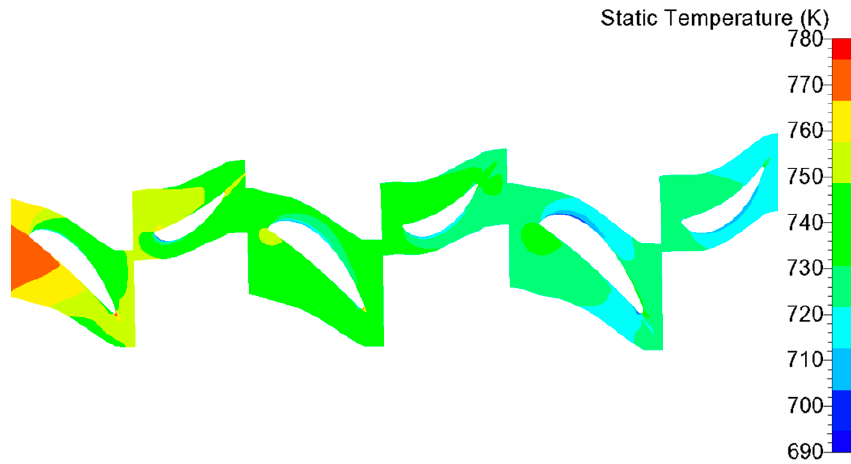
Figure 6. Temperature distribution at the 50% blade height section.